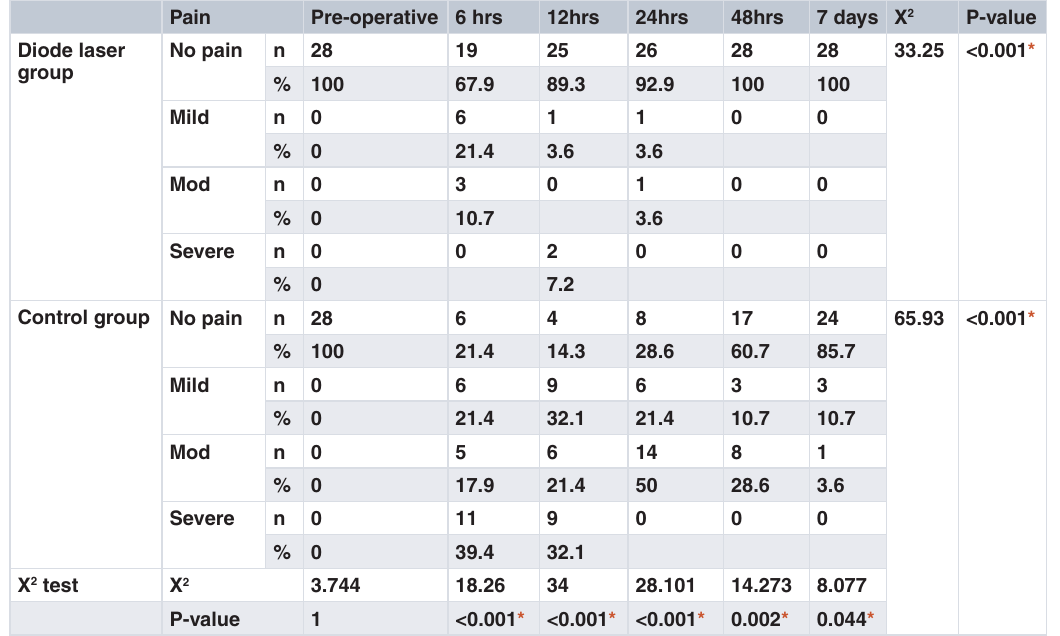
Table 3. Mean and SD values of pain intensity of different time periods within each